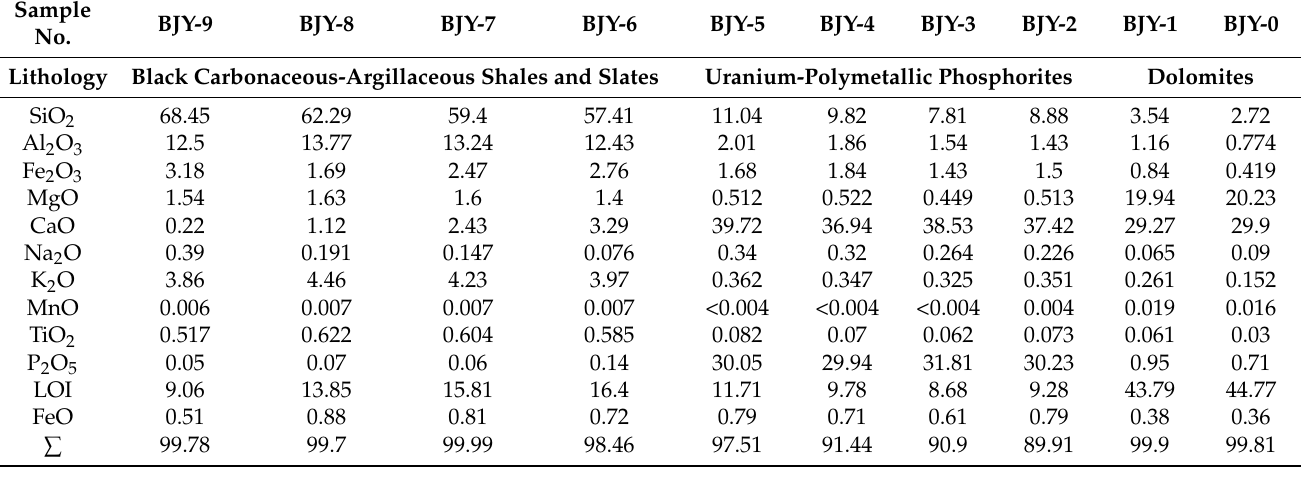
Table 1. The major elements of the samples from the Baizhuyu deposit (w B /%).